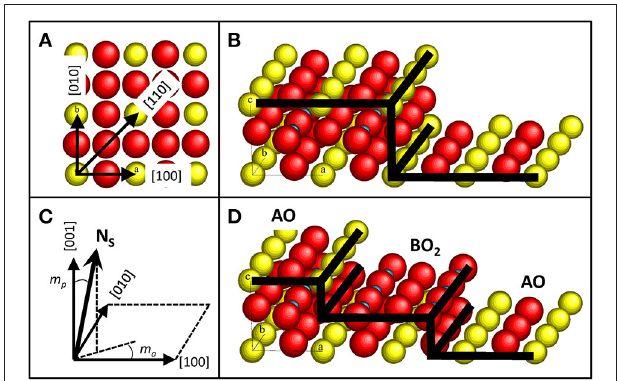
FIGURE 1 | Sketches of oxide single-crystal structure. (A) Sketch of a (001) surface of a perovskite ABO 3 single-crystal showing the lowest Miller indexes directions. (B) Sketch of a (001) surface of a perovskite ABO 3 single-crystal with an unit-cell high atomic step. (C) Sketch of the polar ( m p ) and azimuthal ( m a ) miscut angles, adapted from Bachelet et al. [34]. N s represents the normal to the mean surface. (D) Sketch of a (001) surface of a perovskite ABO 3 single-crystal with a half-unit-cell high atomic step, revealing both alternating chemical terminations AO and BO 2 .